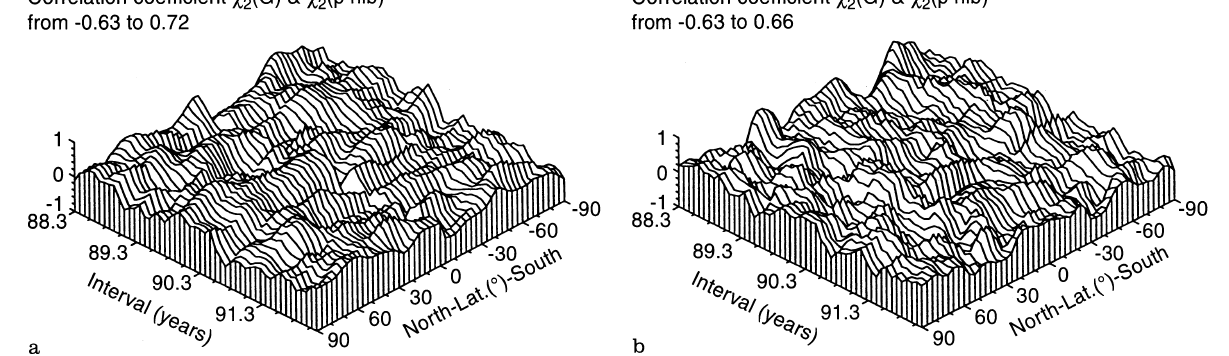
Fig. 5 a, b. Time-variable correlation coe(cid:129)cients between the (cid:118) components of the zonal EAAM (JMA) and geodetic (CSR93L01) excitation functions, computed for intervals of a quarter of a year, in